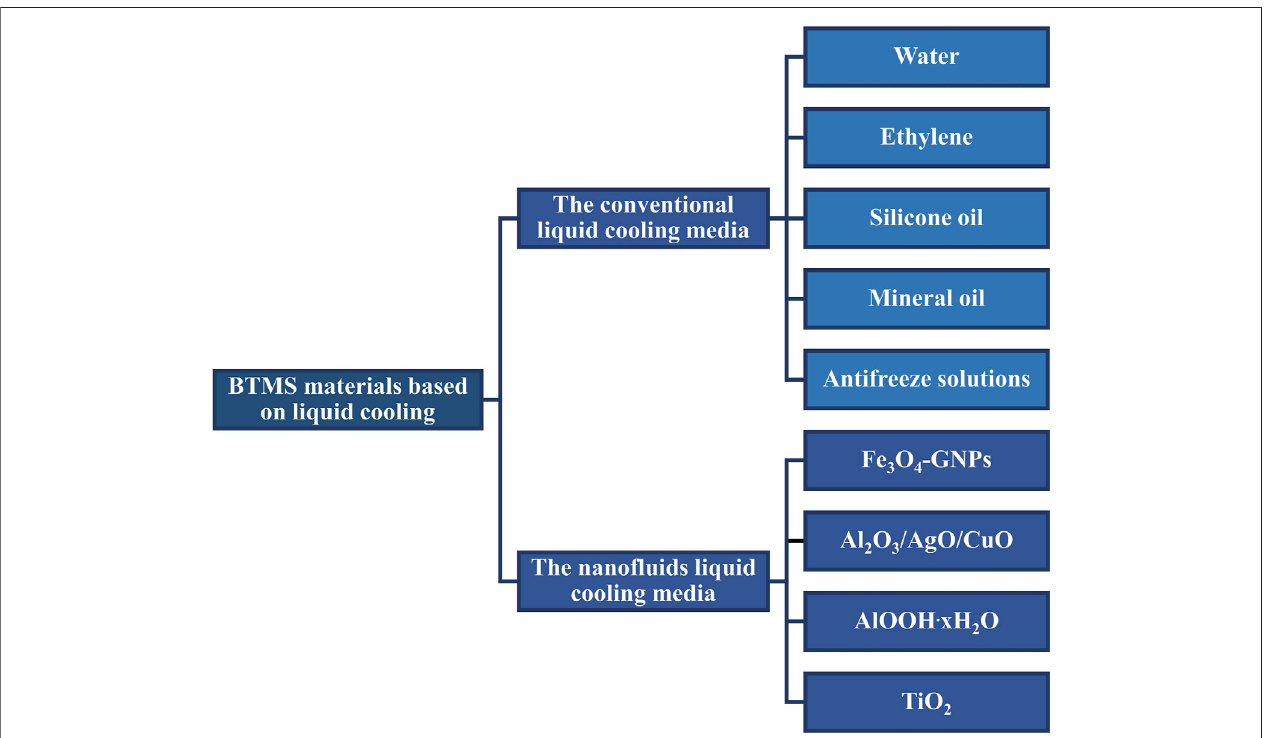
FIGURE 1 | Classi fi cation of liquid medium.